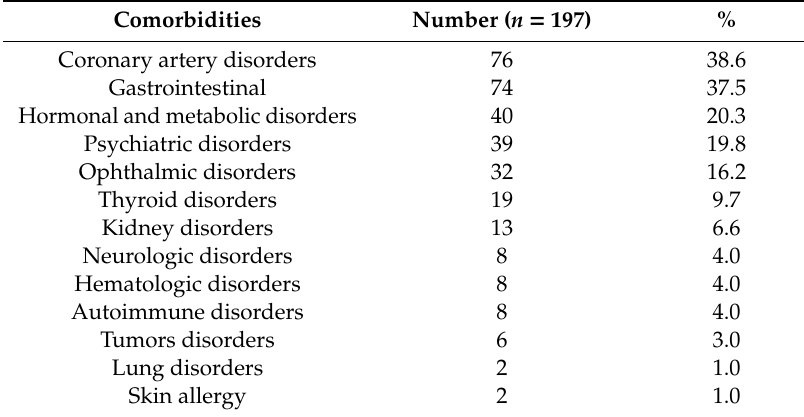
Table 3. Comorbidities associated with chronic HCV infection in patients treated in a reference center between 2015 and